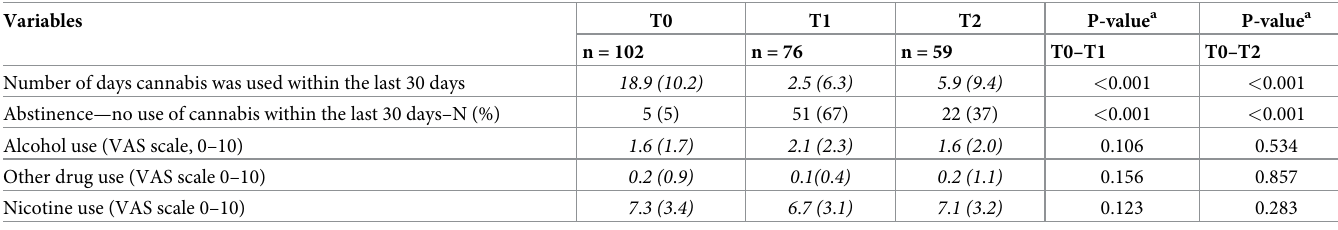
Table 3. Self-reported changes in substance use among study